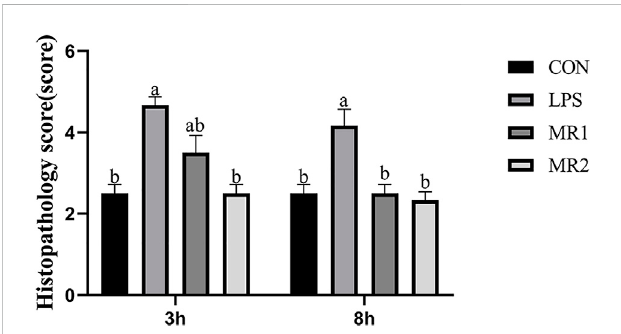
Effects of methionine restriction on histopathological score of liver in broilers stimulated by LPS. Data was shown as the mean ± SEM from six independent experiments. a – c These bars without the same letter indicate differences signi fi cant at p < 0.05. CON, a basal diet plus intraperitoneal administration of sterile saline; LPS, a basal diet plus intraperitoneal administration of LPS; MR1, 0.3% mehtionine restriction diet plus intraperitoneal administration of LPS, MR2, 0.4% mehtionine restrictiondietincombinationwithintraperitonealadministrationofLPS. 3 h, 3 h after LPS stimulation; 8 h, 8 h after LPS stimulation.